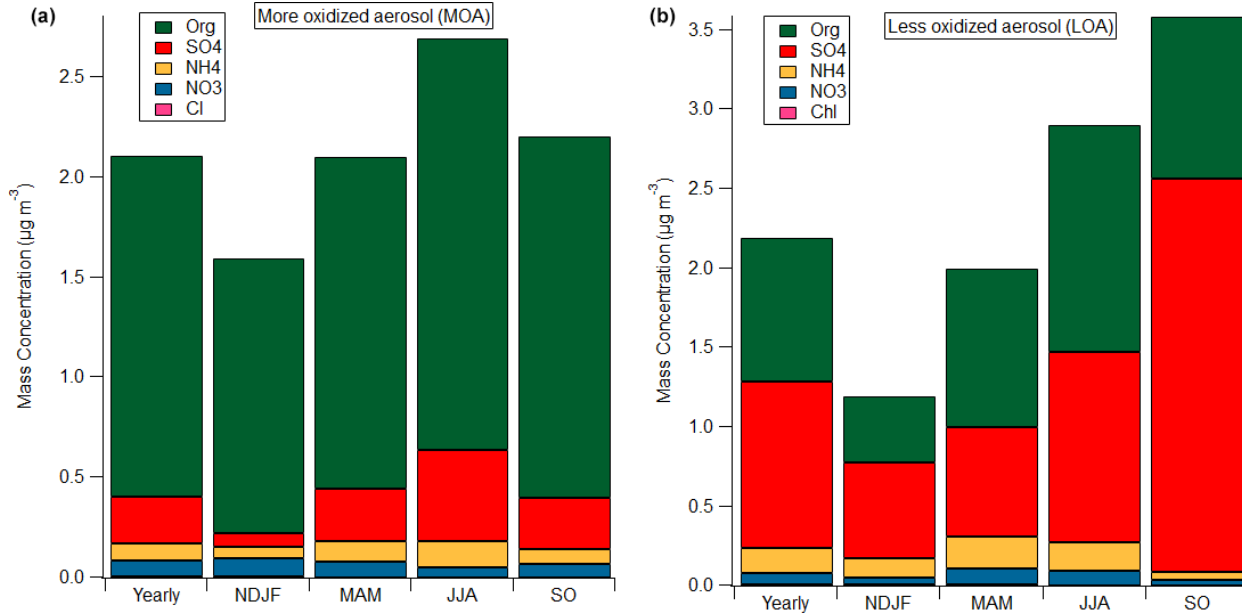
Figure 5. Mass concentration of each species in MOA (a) and LOA (b) in different seasons: yearly, November–February (NDJF), March– May (MAM), June–August (JJA) and September–October